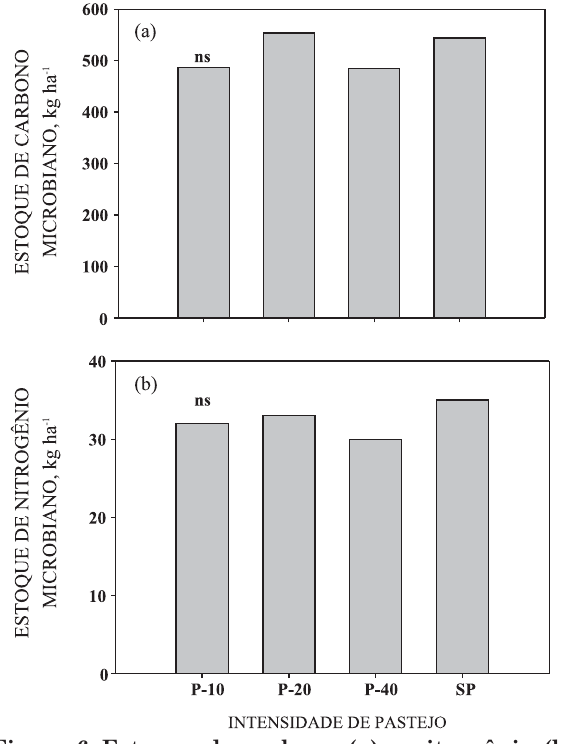
Figura 6. Estoque de carbono (a) e nitrogênio (b) médio na biomassa microbiana, na camada de 0 a 10 cm, de um Latossolo Vermelho em função de intensidades de pastejo em sistema de integração lavoura-pecuária sob plantio direto. P-10, P-20, P-40 e SP representam as alturas de 10, 20, 40 cm e sem pastejo, respectivamente. ns: